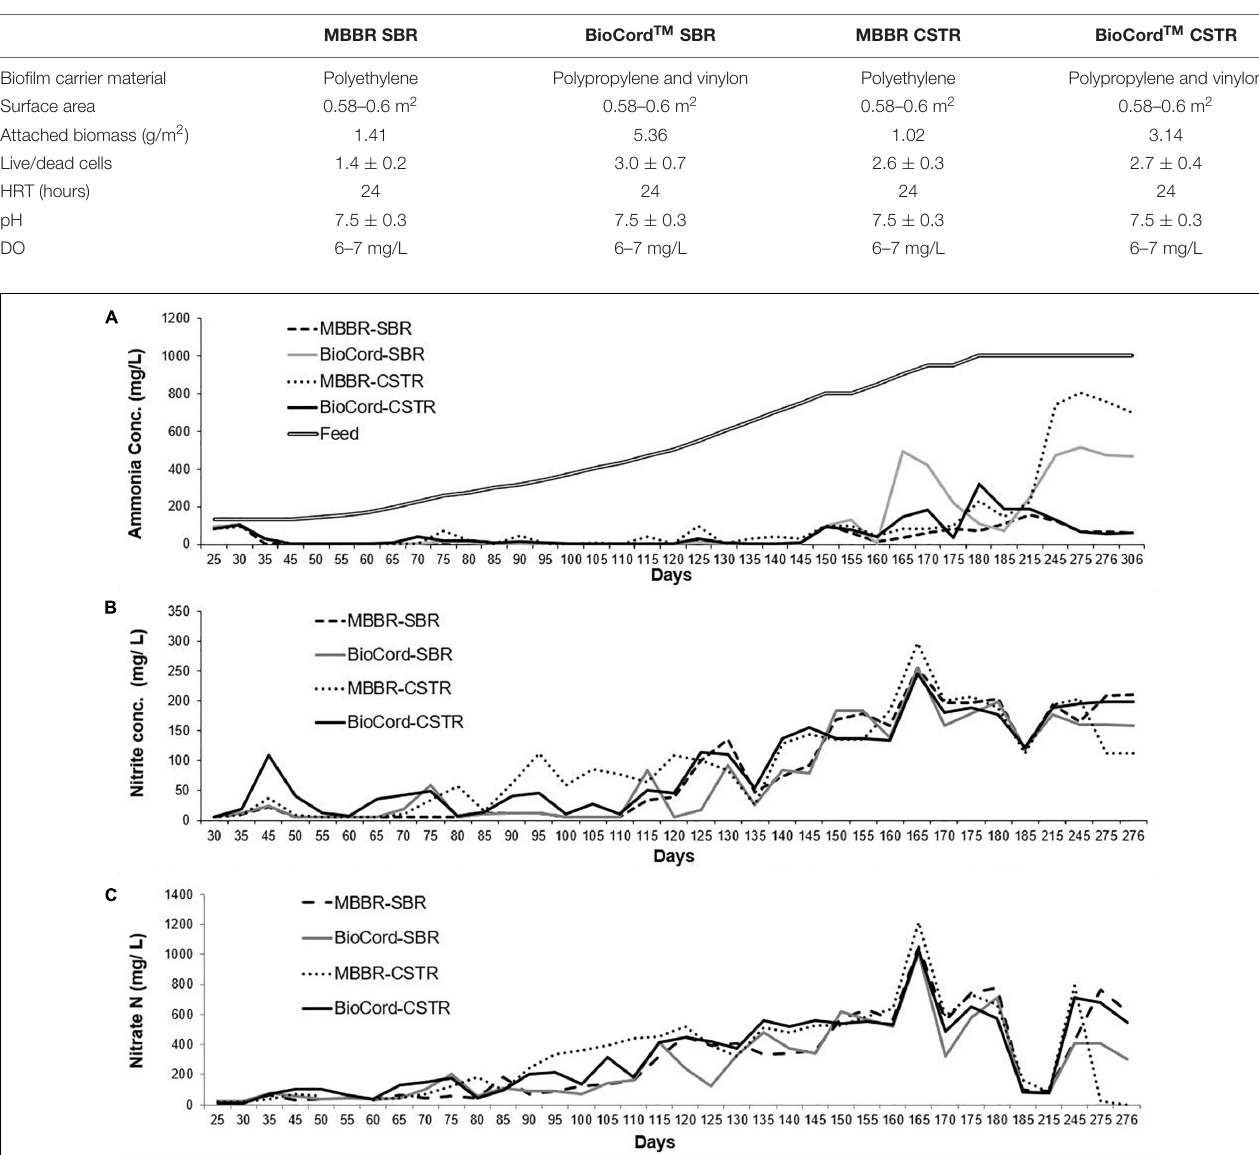
TABLE 1 | Operational conditions of the fixed-film and hybrid bioreactors.